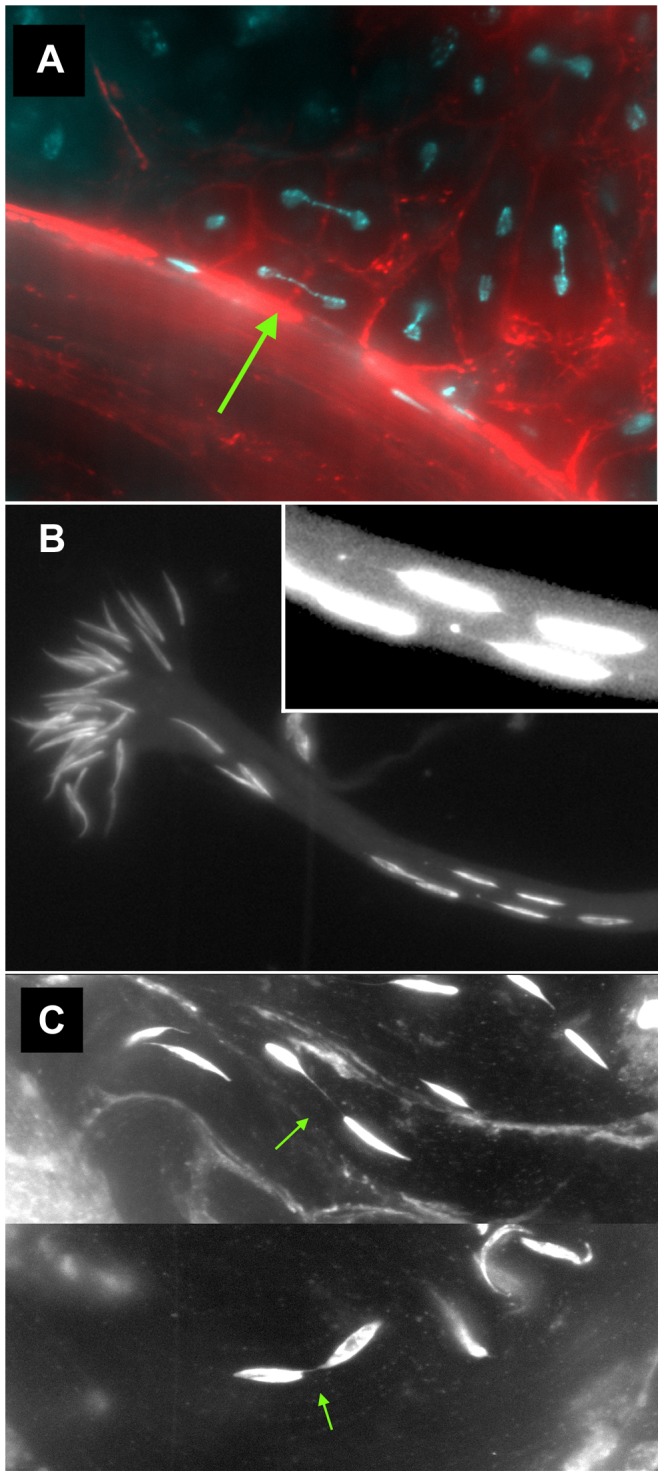
Meiotic and spermatid phenotypes of lok males after dicentric chromosome induction.
y w 70FLP3F/DcY(H1); lokP6 males were heat-shocked at 38° for 1 hr during the first 24 hours of development, then dissected within 24 hrs of eclosion and stained with DAPI (blue) and phalloidin coupled to rhodamine or FITC (red). (A) Y chromosome dicentric bridges were frequently observed in MII, even in cells with near complete cytokinesis (arrow). (B) Sperm heads were often displaced from the bouquet of differentiating heads. The displaced heads were frequently mis-shapen, with some showing threads of trailing chromatin (inset - brightness increased to aid visualization). (C) Displaced sperm heads were sometimes connected by thin chromatin bridges.